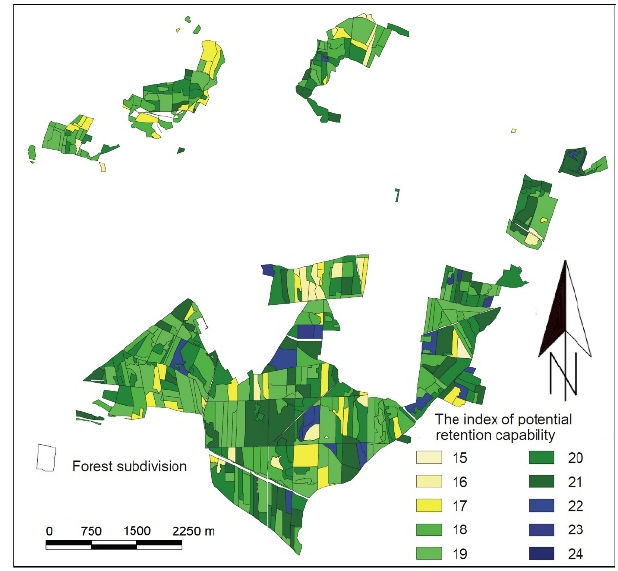
Figure 6. Potential retention capacity of forest areas based on the Unieszów Experimental Forest [68].